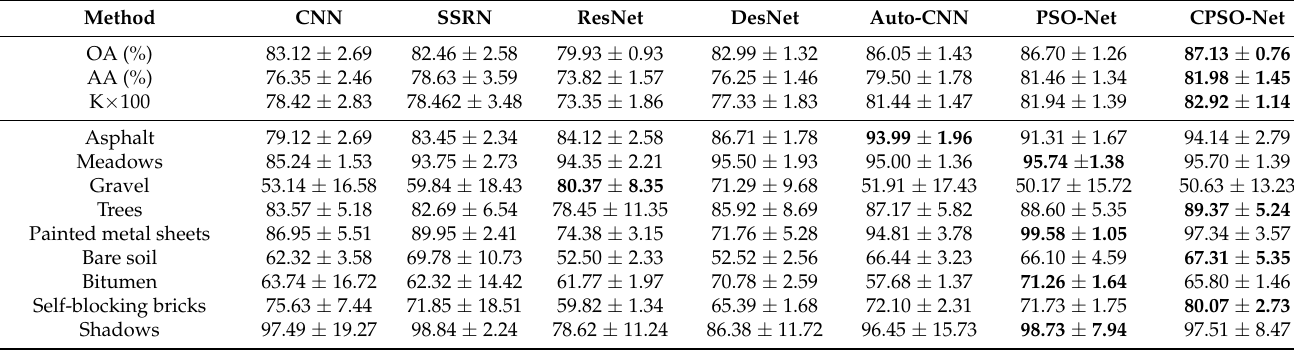
Table 8. Classification accuracy with bolding the best accuracy based on the unbiased Pavia dataset, run five times. Method